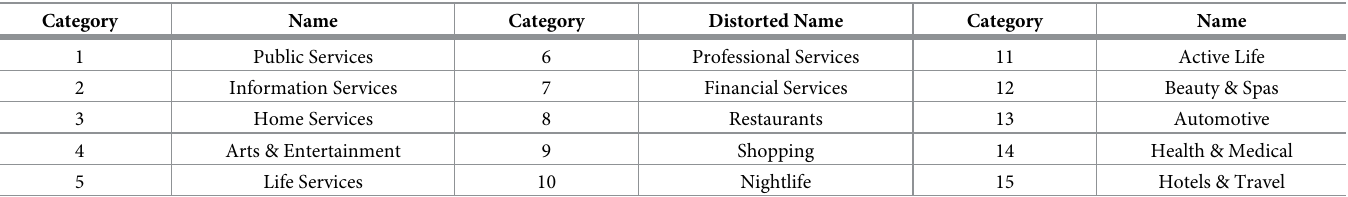
Table 2. 15 categories of semantics in Combination Dataset.